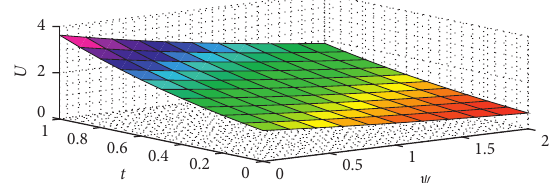
Figure 6: The surface graph of the approximated solution ( ψ ,t, ρ ) for α � 1 . 0. U 3